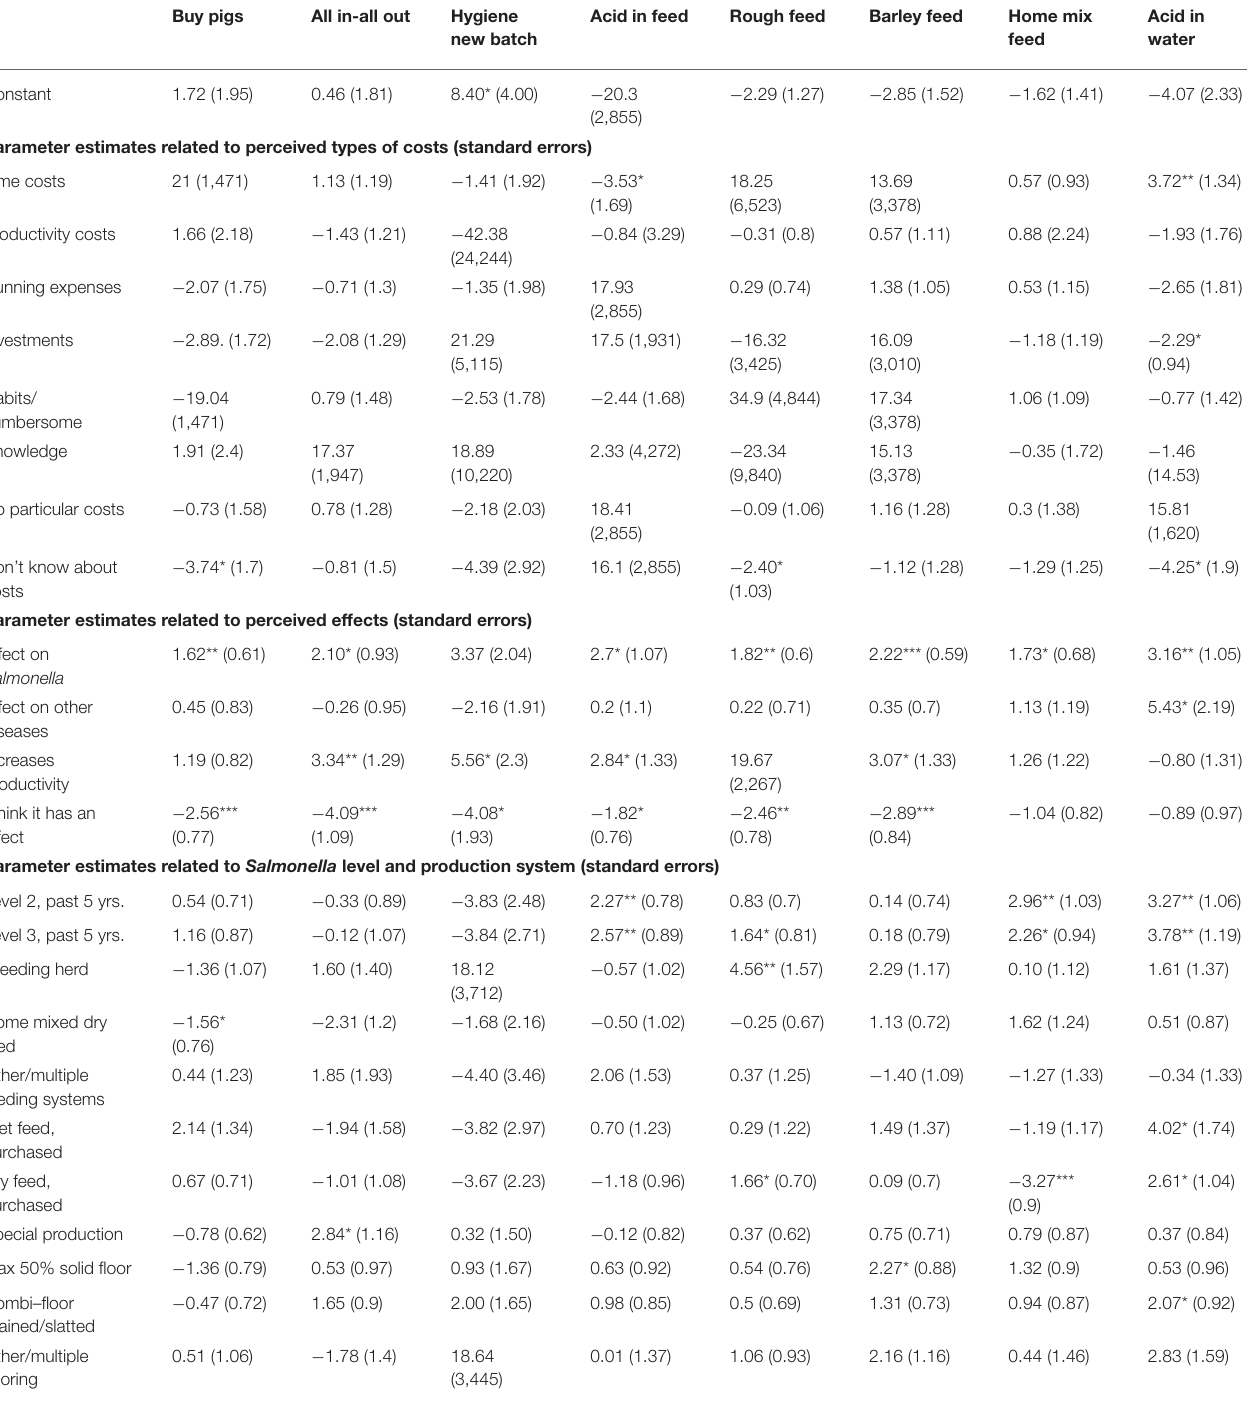
TABLE 9 | Logistic regression model explaining the choice of Salmonella control with variables related to perceptions of costs and effects, Salmonella level in the herds as well as herd characteristics. Buy pigs All in-all